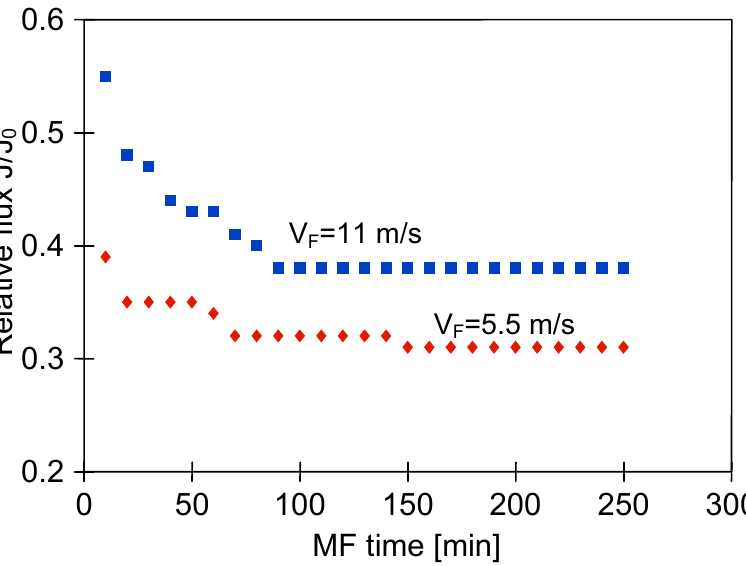
Figure 7. Effect of feed flow velocity on the relative permeate flux during MF of 1,3-PD fermentation broth with Citrobacter freundii . Module M4, TMP = 0.08 MPa, J 0 = 311 l/m 2 h.